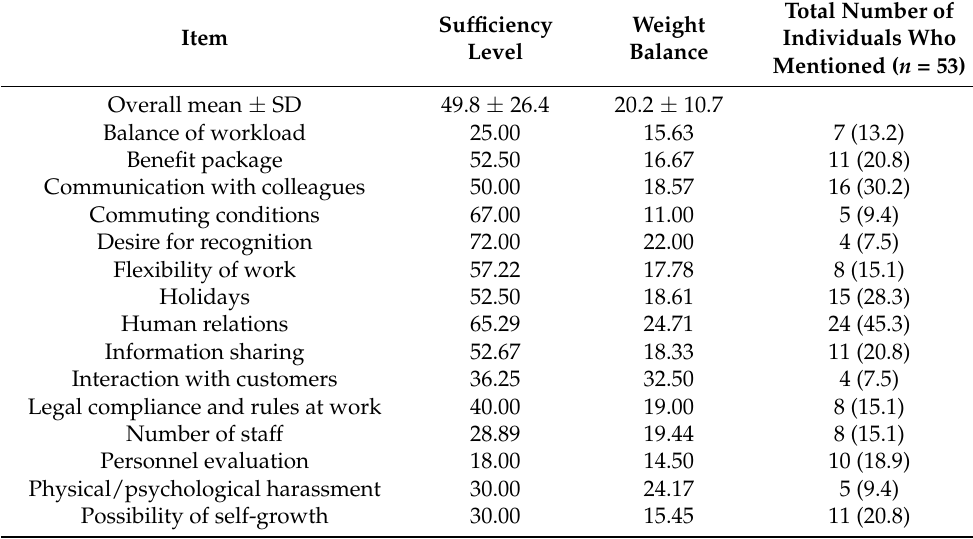
Table 5. Work-improvement needs items, sufficiency level, weight balance, and total number of individuals who mentioned the corresponding item in